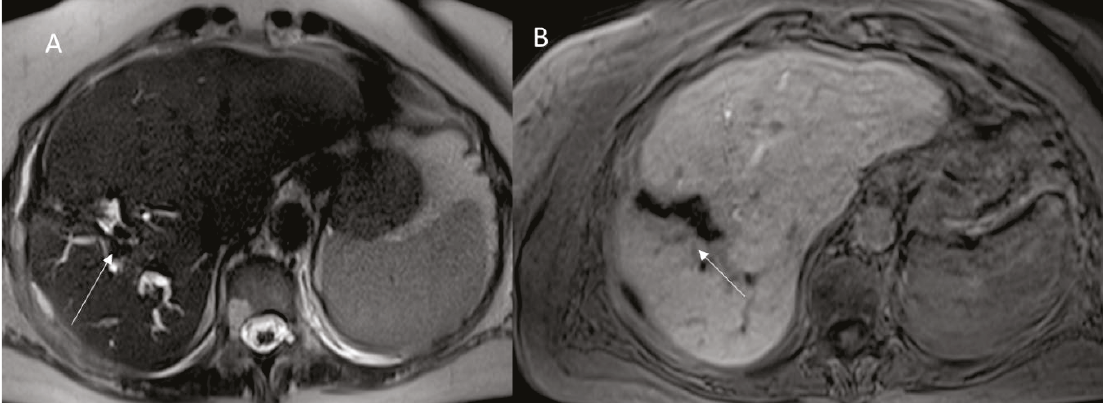
Figure 3. The same patient of Figure 2, MRI assessment (( A ): HASTE T2-W sequence, ( B ): EOB-Phase of contrast study) after 2-month, arrow shows biloma.